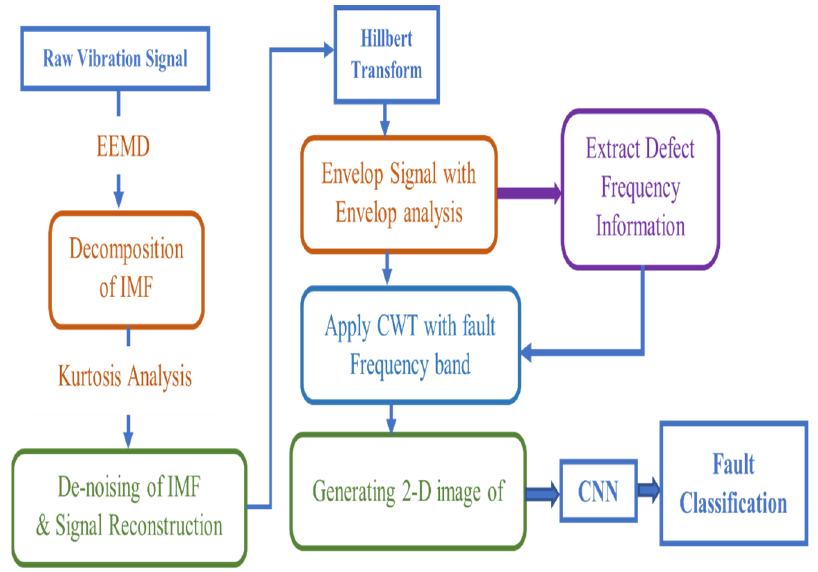
Figure 2. Overall process of the EEMD + CWT-based bearing fault classification approach.